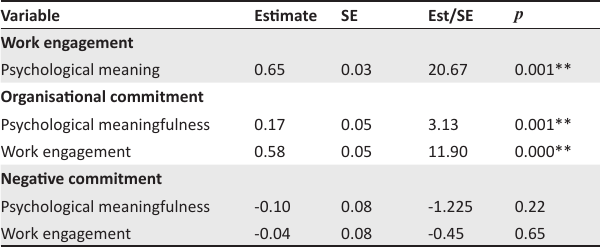
TABLE 3 : Standardised regression coefficients of the variables.